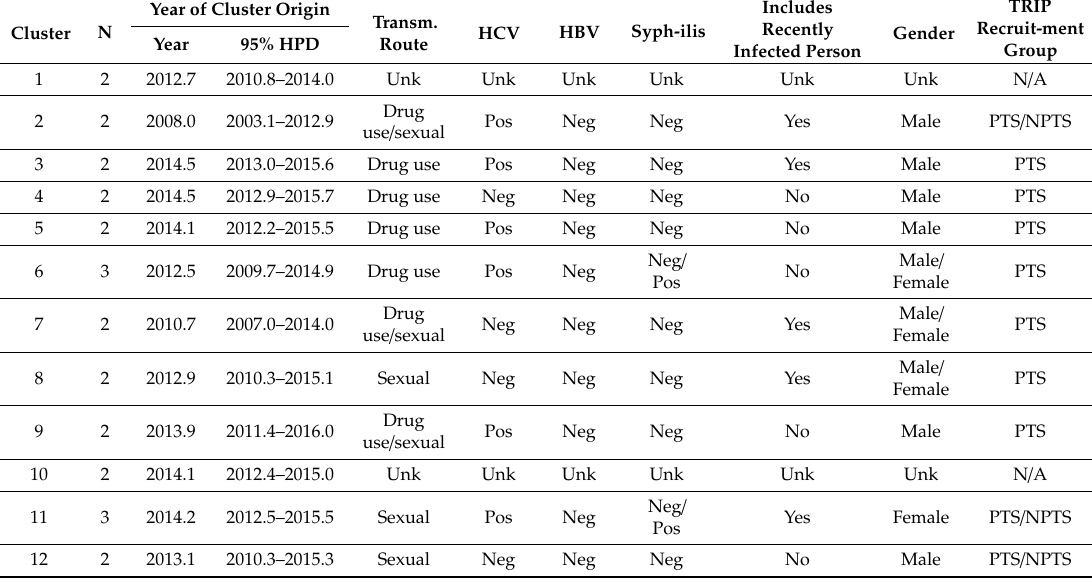
Table 2. Potential transmission clusters identified in